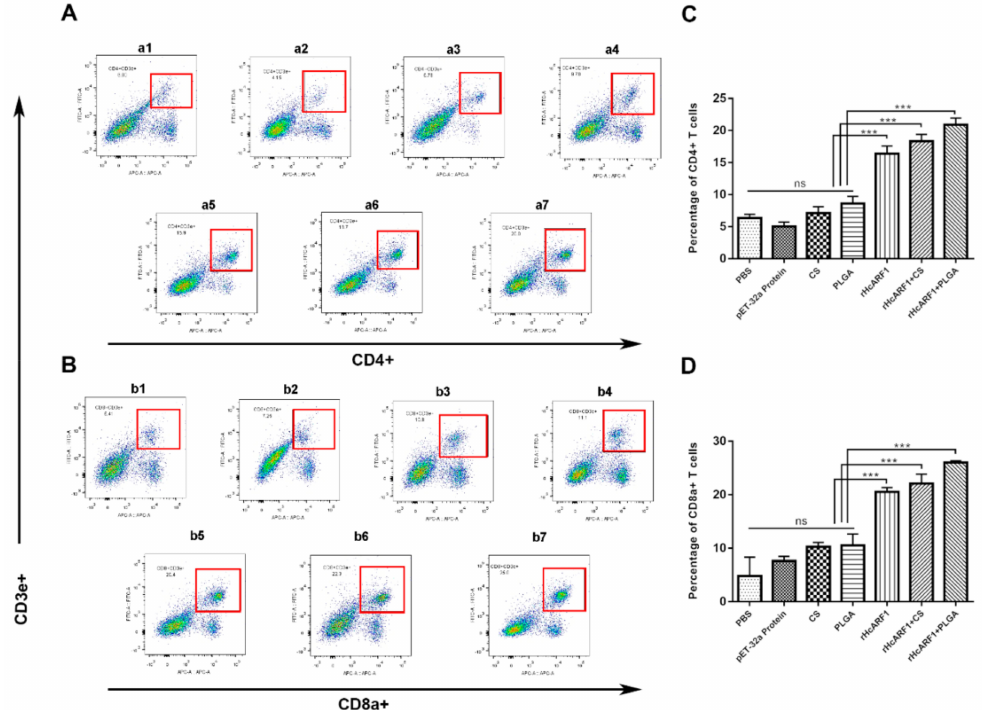
Figure 6. The proportions of CD4 + T cells and CD8 + T cells in all groups of mice a ff ected by antigen-loaded nanoparticles. The percentages of CD4 + T cells (( A ) ( a1 – a7 )) and CD8 + T cells (( B ) ( b1 – b7 )) in seven groups could be shown as dot plots (( a1 , b1 ): PBS group. ( a2 , b2 ): pET-32a protein group. ( a3 , b3 ): CS group. ( a4 , b4 ): PLGA group. ( a5 , b5 ): rHcARF1 group. ( a6 , b6 ): rHcARF1 + CS group. ( a7 , b7 ): rHcARF1 + PLGA group, respectively determined by flow cytometry. The bar graphs show di ff erent treatments that a ff ected the proportions of CD4 + T cells and CD8 + T cells ( C , D ). The results shown here are from an independent experiment that is representative of three independent experiments (*** p <